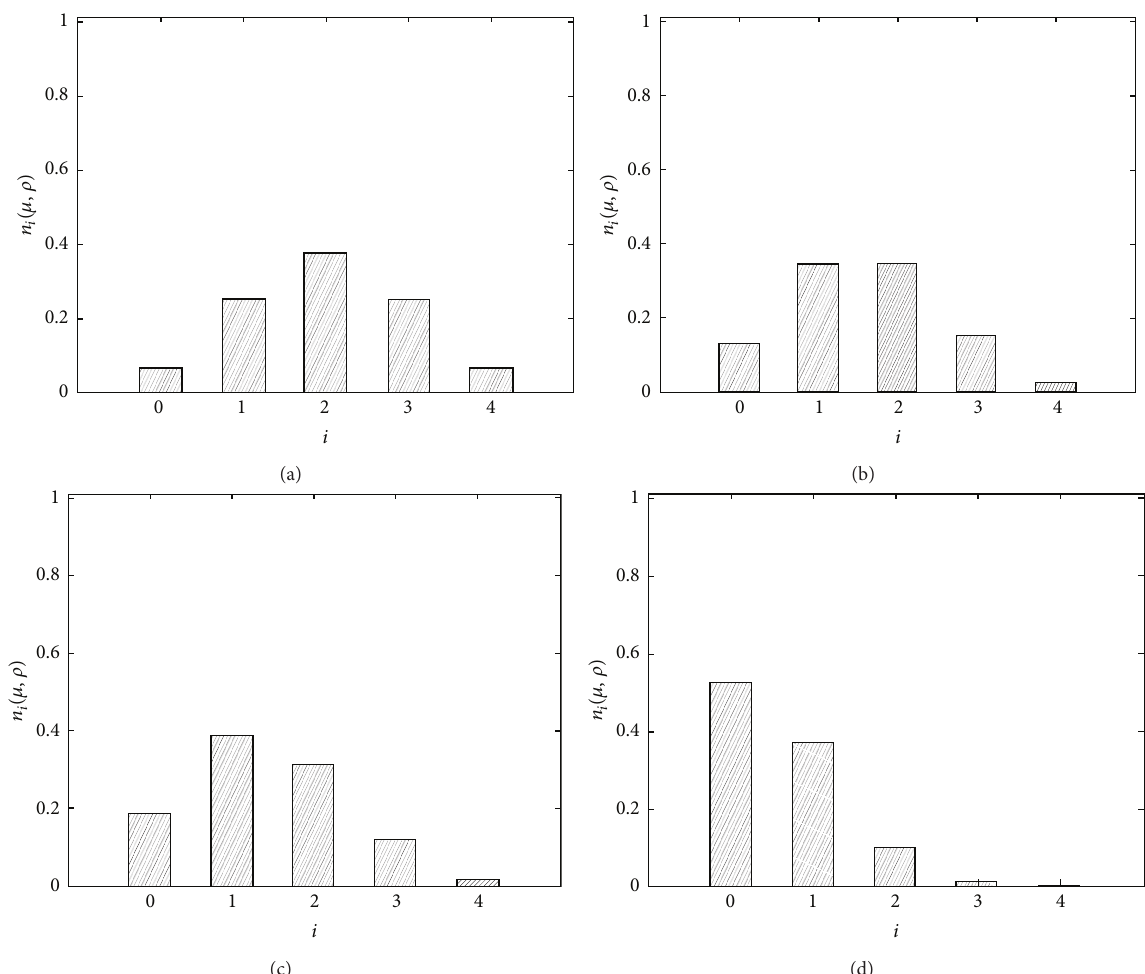
Figure 7: Relative fraction of players belonging to rank 𝑖 for different values of 𝜌 when 𝜇 = 0.5 : (a) 𝜌 = 1.0 ; (b) 𝜌 = 0.8 ; (c) 𝜌 = 0.7 ; (d) 𝜌 = 0.4 . For 𝜌 = 0.8 , most players still occupy the three middle ranks, which indicates that the feedback mechanism in (b) is similar to that in (a). Nevertheless, the empty sites prohibit defectors to exploit cooperators, and thus the level of cooperation is substantially enhanced in the region of 1.0125 ≤ 𝑏 ≤ 1.2125 when 𝜌 = 0.8 , as shown in Figure 1. However, for 𝜌 = 0.7 , most players occupy three lower ranks, while only a few players emerge in two higher ranks as shown in (c), which drastically weaken the feedback mechanism. Despite that cooperators may still benefit from the dilution, the level of cooperation remarkably decreases by comparison with that for 𝜌 = 0.8 , as shown in Figure 1. When 𝜌 = 0.4 , as shown in (d), almost all players occupy three lower ranks and nearly none occupy two higher ranks. This kind of rank distribution results in a further decrease of 𝜌 𝑐 /𝜌 , as shown in Figure